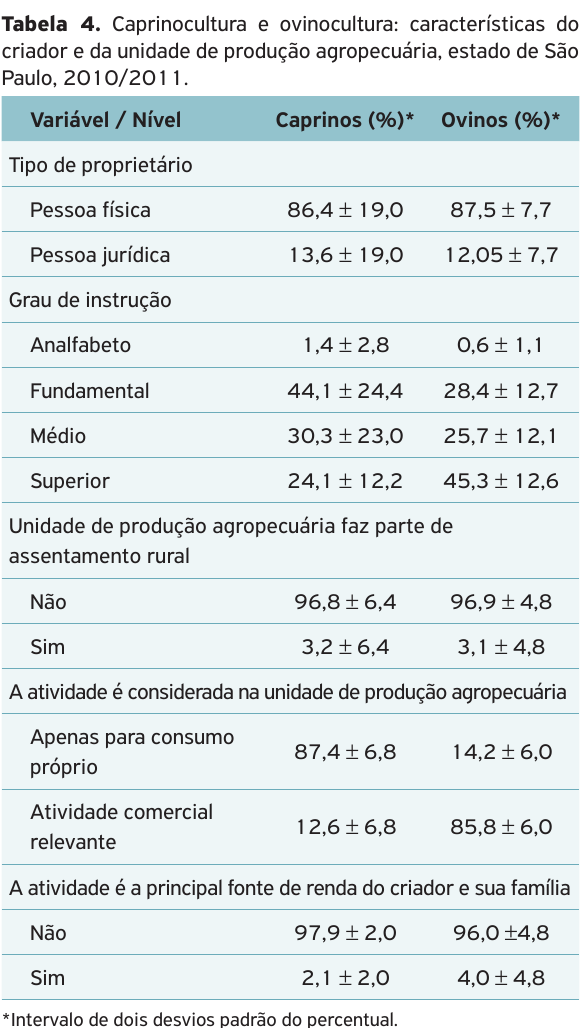
*Intervalo de dois desvios padrão da média. Fonte: Instituto Biológico.